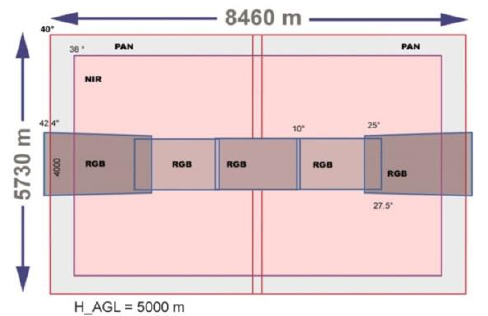
Figure 7: The UltraCam-G technology is based on the design of the UltraCam family (Senor Unit, Data Storage Unit and User Interface Panel) but has a new 7-cone concept shown on the right.